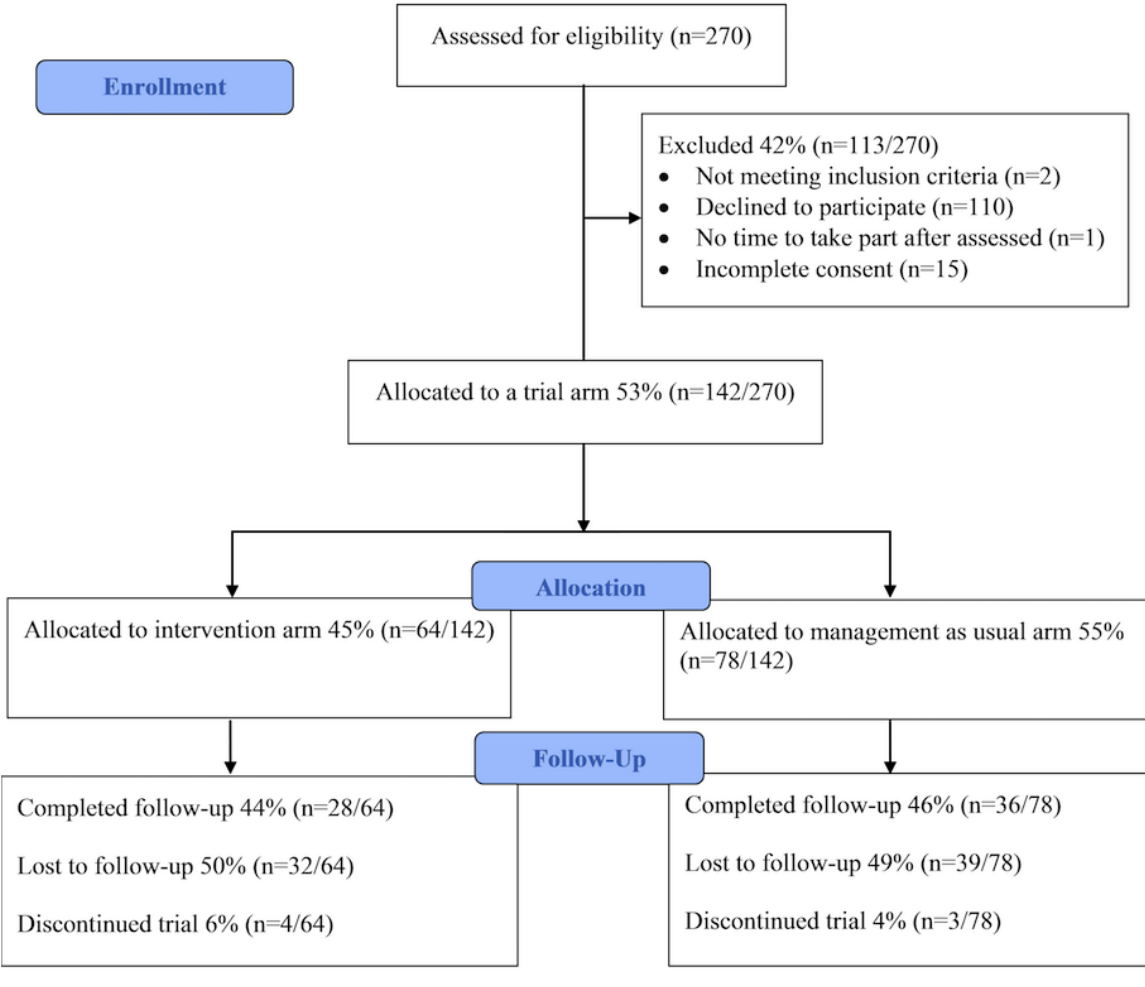
Figure 2. Consolidated Standards of Reporting Trials diagram: combined flow of participants through the study across both specialist services and schools strands of the